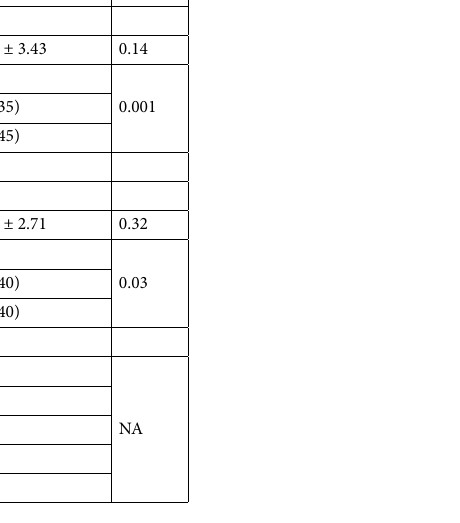
Table 1. Farm 1, Farm 2, and free-ranging deer